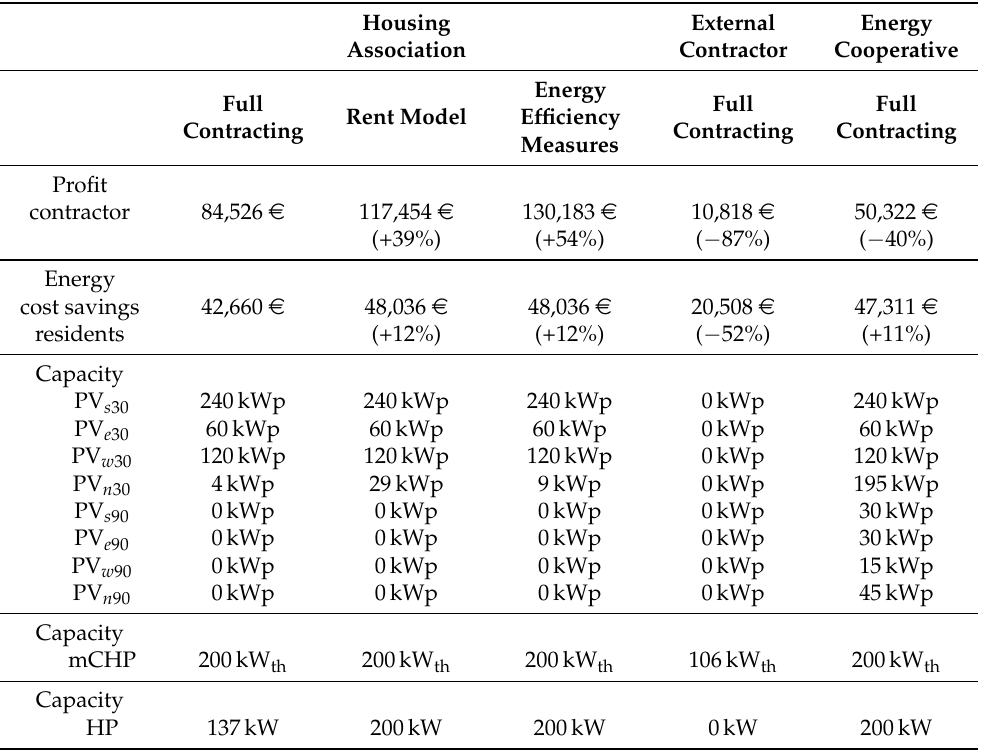
Table 8. Comparison of contractor’s and residents’ annual profits for examined business